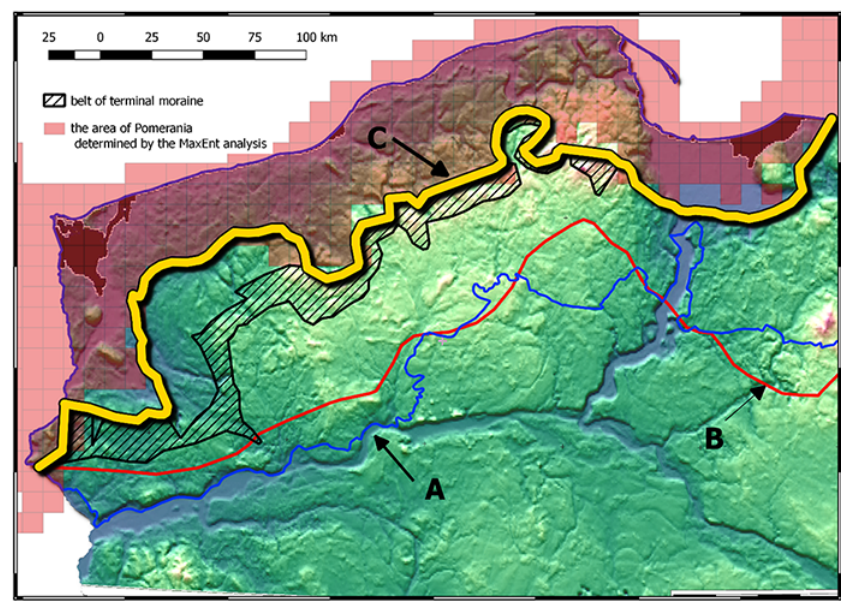
Fig. 7 Results of the MaxEnt analyses of the normalized sum averaged by 100 outputs grids where the bootstrap model is equal or higher than 0.6. ( A ) Southern border of geobotanical distinction of Pomerania according to Matuszkiewicz [4]. ( B ) Southern border of geobotanical distinction of Pomerania according to Szafer [3]. ( C ) Southern border of geobotanical distinction of Pomerania according to current